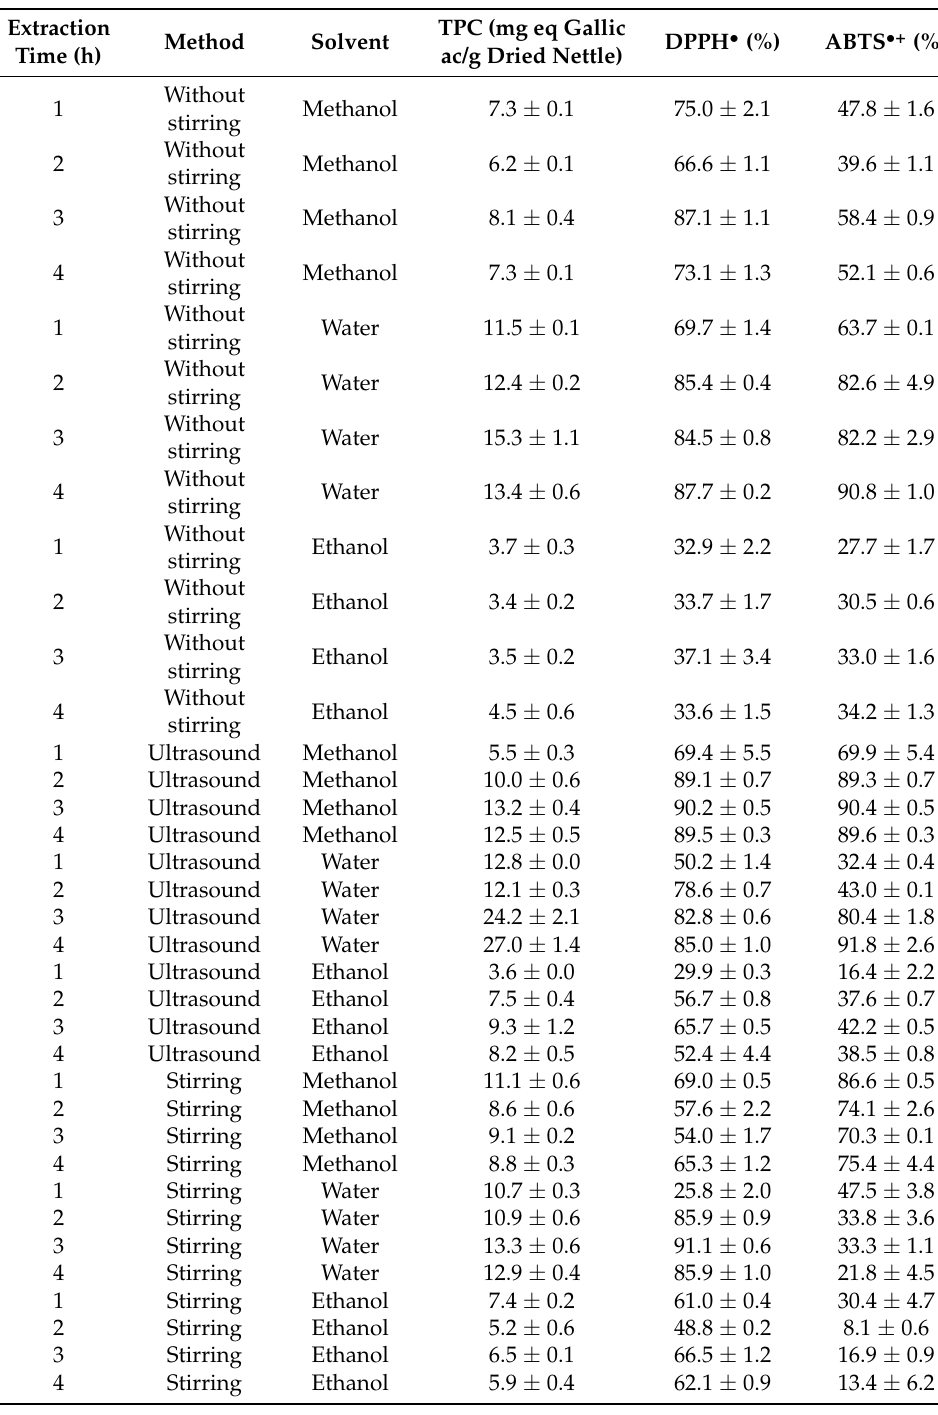
Table 1. Experimental design and results for antioxidant variables of dried nettle extracts. TPC is Total Phenolic Content, DPPH • is 1,1-Diphenyl-2-picrylhydrazyl assay and ABTS • + is 2,2-azino-bis(3- etilbenzotiazolin)-6-sulfonic acid